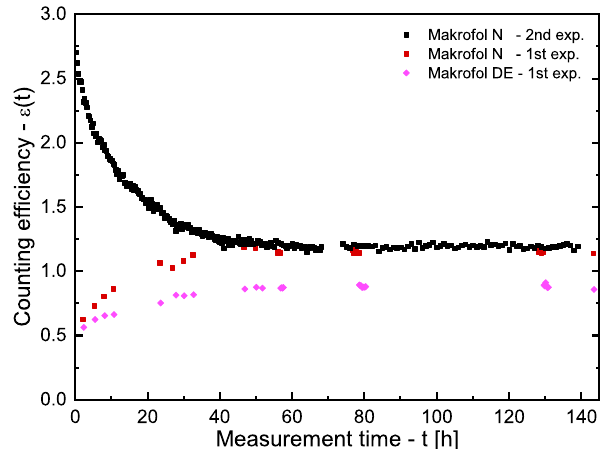
Figure 2. Cherenkov-counting efficiencies as a function of time for the two types Makrofol foils immersed in water. The uncertainties (not shown) at the level of 1 σ are about 5% for the points from the first experiment and about 3% for the points from the second experiment. Table 1. Counting efficiencies for: polymer foils in distilled water counted in Cherenkov mode (1–6), distilled water counted in Cherenkov mode (7) and Makrofol N foil dissolved in toluene based liquid scintillation cocktail (LSC) (8). The counting efficiencies are given after reaching equilibrium distribution between radon concentration in the two phases (polymer–water) and/or equilibrium of radon and its short-lived progeny, i.e., these are steady-state counting efficiencies. For (1–4, 7,8), equilibrium is reached after 3–5 h and for (5,6) equilibrium is reached after 60–70 h. No Sample Counting